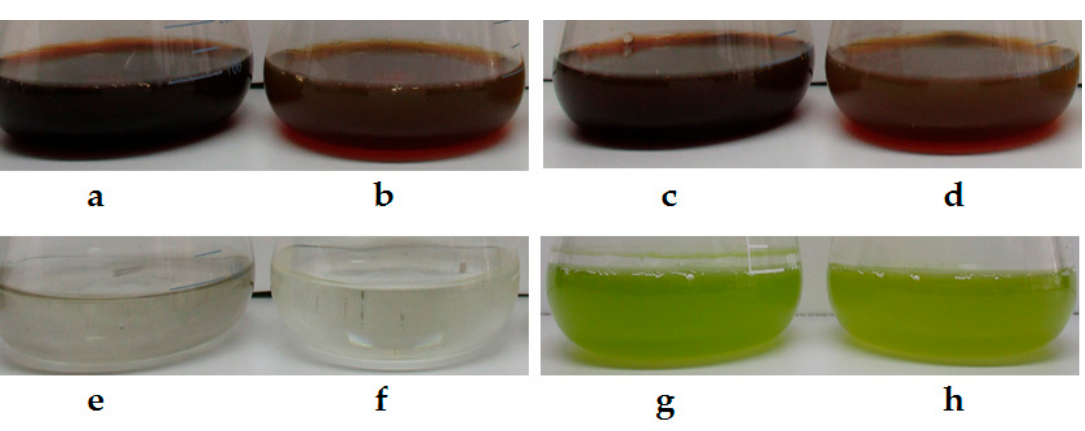
Figure 1. Photographic images of 500 mL Erlenmeyer flasks after 48 h of cultivation. The strain (WT or CWD) and concentration of AgNO 3 are indicated for each flask. ( a ) WT-1.250 mM; ( b ) WT-0.625 mM; ( c ) CWD-1.250 mM; ( d ) CWD-0.625 mM; ( e ) BBM + 1.250 mM; ( f ) BBM + 0.625 mM; ( g ) WT-0.000 mM; and ( h ) CWD-0.000 mM.